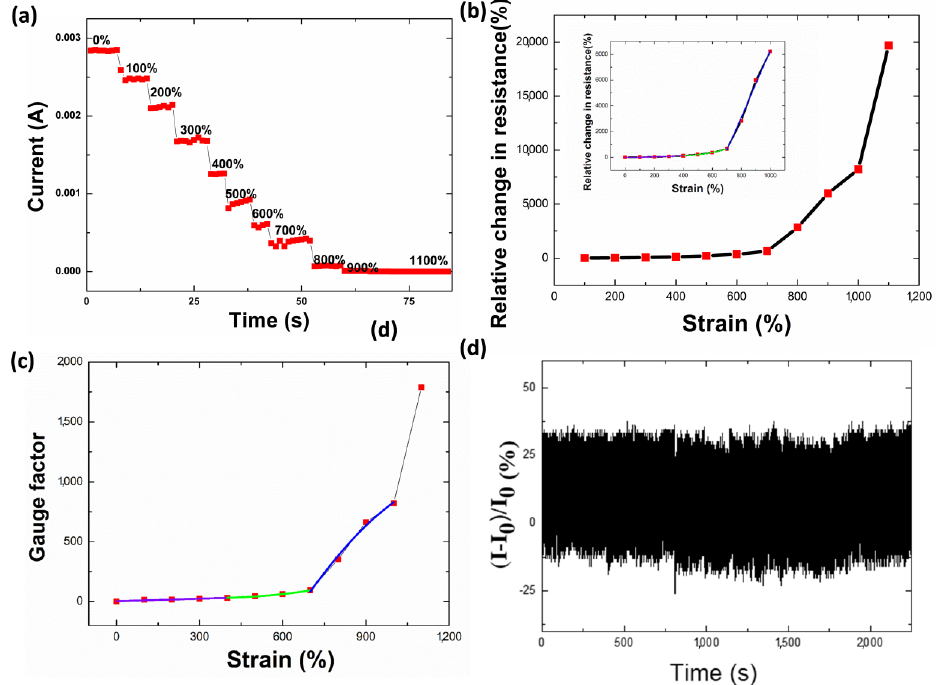
Figure 5. ( a ) I-T characteristic behavior of the TPU / graphene composite strain sensor with an intertwined-coil configuration under di ff erent tensile strains. ( b ) Plots of relative resistance change versus strain of the TPU / graphene composite strain sensor with an intertwined-coil configuration in the range of 0% to 1100% strain. The insert is the relative resistance change versus strain of the TPU / graphene composite strain sensor with an intertwined-coil configuration in the range of 0% to 1000% strain. ( c ) Plots of gauge factor versus strain of the TPU / graphene composite strain sensor with an intertwined-coil configuration. ( d ) One thousand cycles of a repeated stretching–releasing test under strain from 0% to 150%.